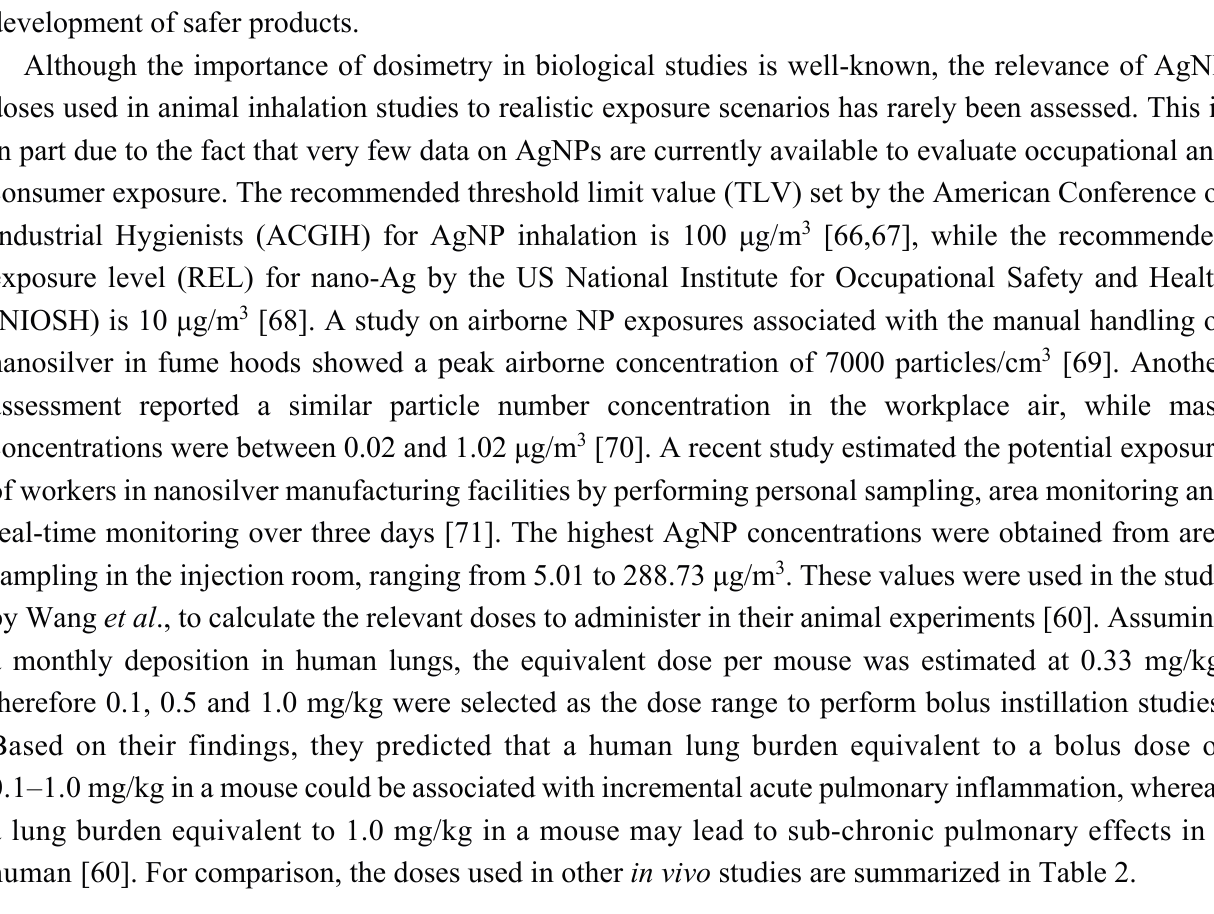
Table 2. Exposure doses used in in vivo studies of silver